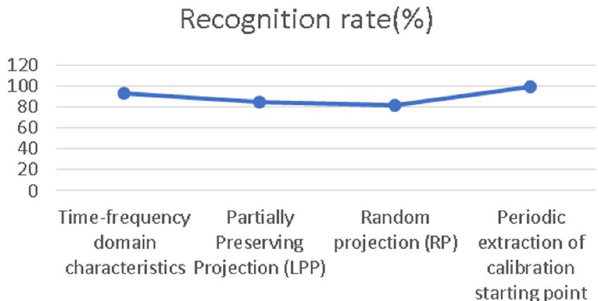
Fig. 6 Comparison of algorithm results based on WARD. LPP, partially preserving projection; RP, random projection; WARD, wearable sensor behaviour recognition database.